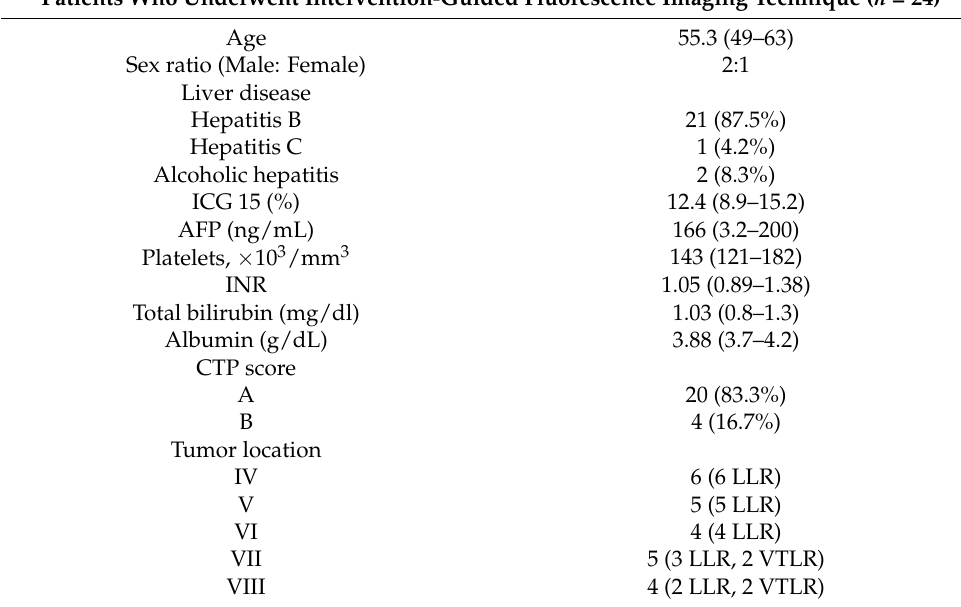
Table 1. Clinicopathologic data of the patients enrolled in the current study. Patients Who Underwent Intervention-Guided Fluorescence Imaging Technique ( n = 24)